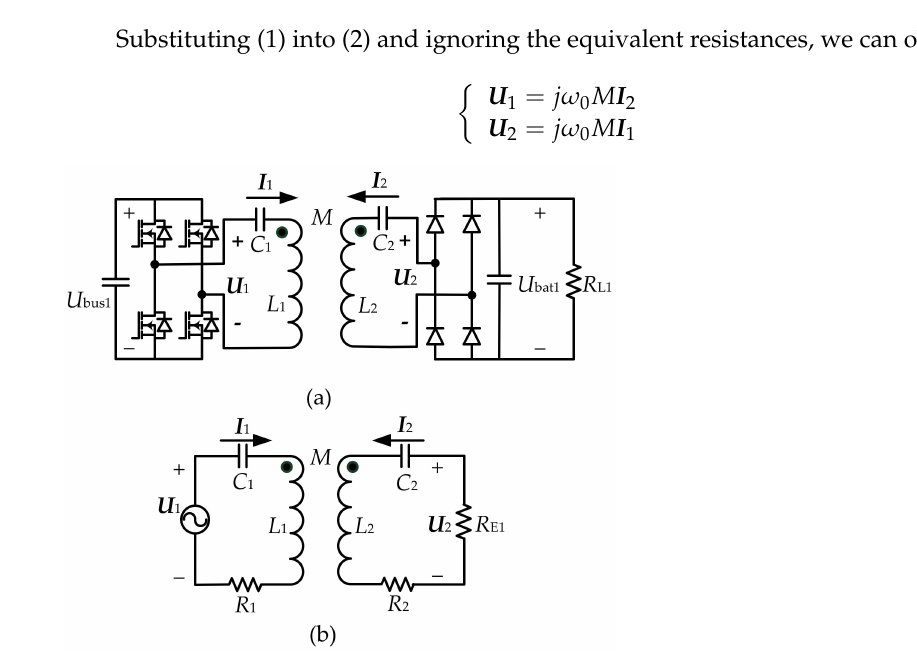
Figure 1. The SS-compensated IPT system. ( a ) The circuit topology; ( b ) the equivalent circuit.